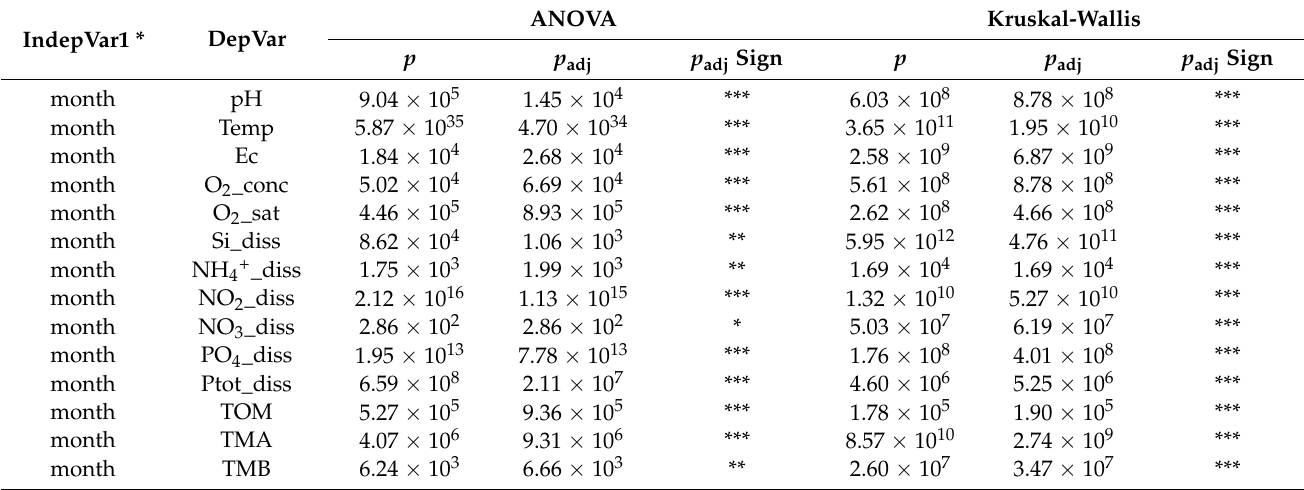
Table 1. One-way ANOVA computed for environmental variables.